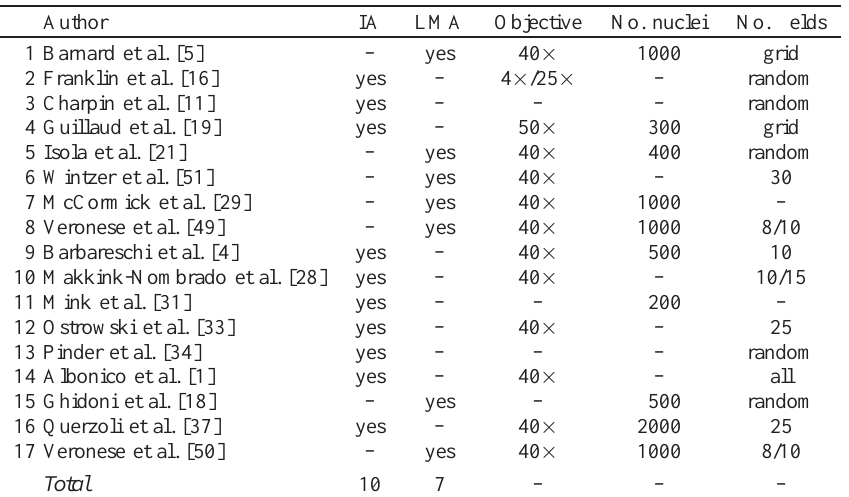
Table 6 Quantitative analysis of PI index in breast cancer: review of the